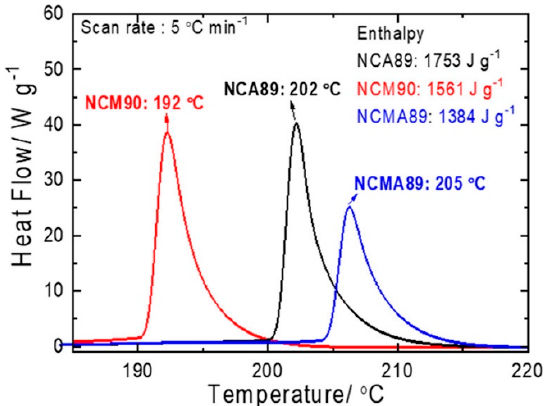
Figure 12. DSC profiles for the NCA89 (i.e., NCA with 0.89 Ni), NCM90, and Li[Ni 0.89 Co 0.05 Mn 0.05 Al 0.01 ]O 2 (NCMA89) cathodes measured in their second charged state (Li 0.3 M O 2 ) in the presence of 1.2 mol L − 1 LiPF 6 EC:EMC = 3:7 by vol.% with 2 wt.% VC. Reproduced with permission from [246]. Copyright 2019 The American Chemical Society.